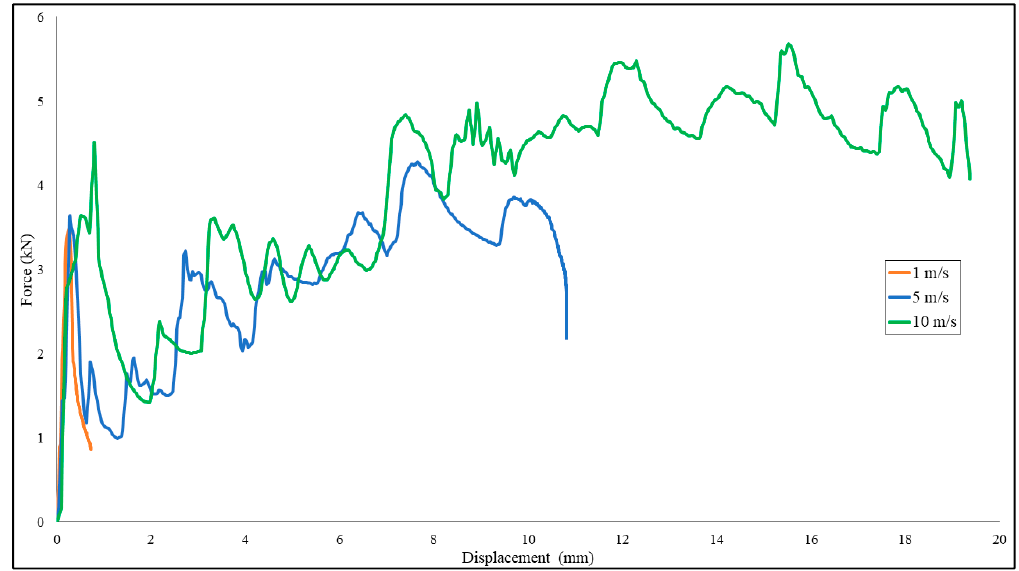
Figure 21. Force–displacement curves of battery model with impact loading of 1, 5, and 10 m/s.